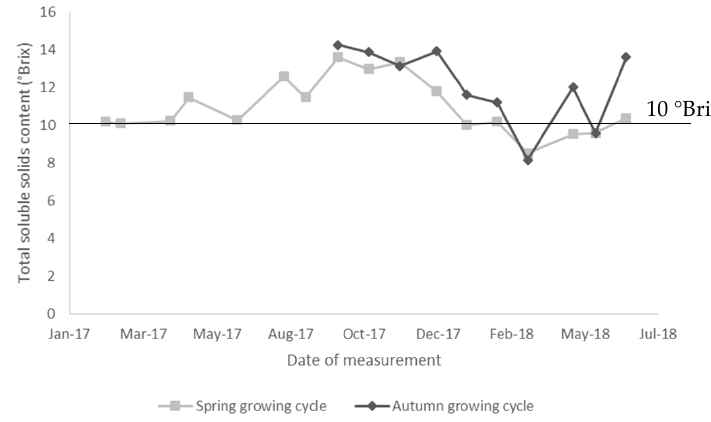
Figure 4. Total soluble solid content (TSS) changes during the year in fruits from spring versus autumn growing cycle. The line marks the 10 ◦ Brix value, commonly referred to as the minimum required for papaya commercialization.